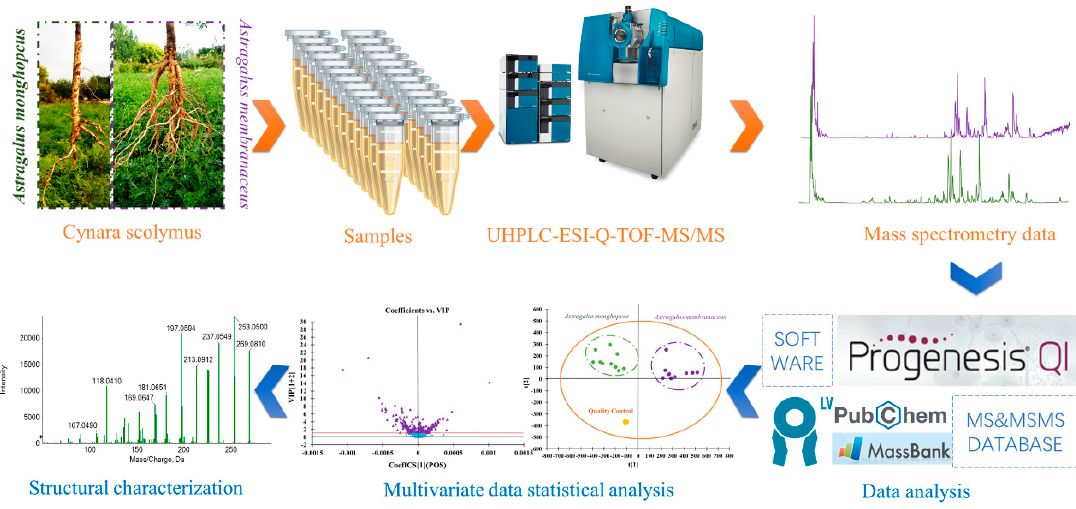
Figure 1. The experimental procedures for chemical discrimination of Astragalus mongholicus (MG) and Astragalus membranaceus (MJ).